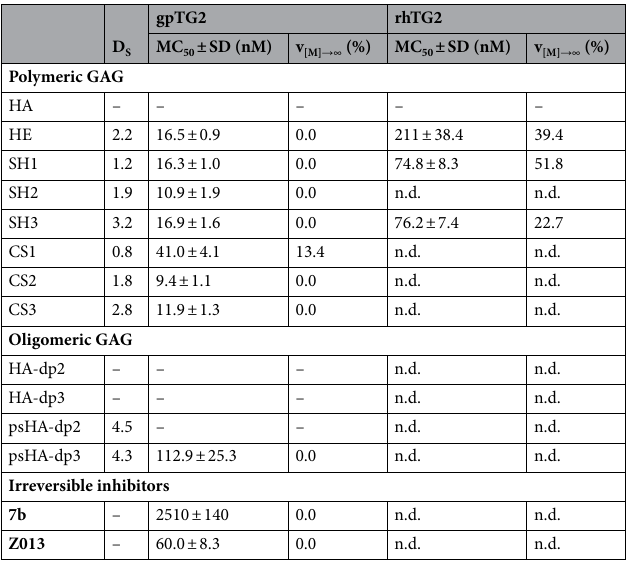
Table 1. MC 50 values for gpTG2 and rhTG2 of the investigated polymeric and oligomeric GAG derivatives and the irreversible inhibitors. – no inhibition, n.d. not